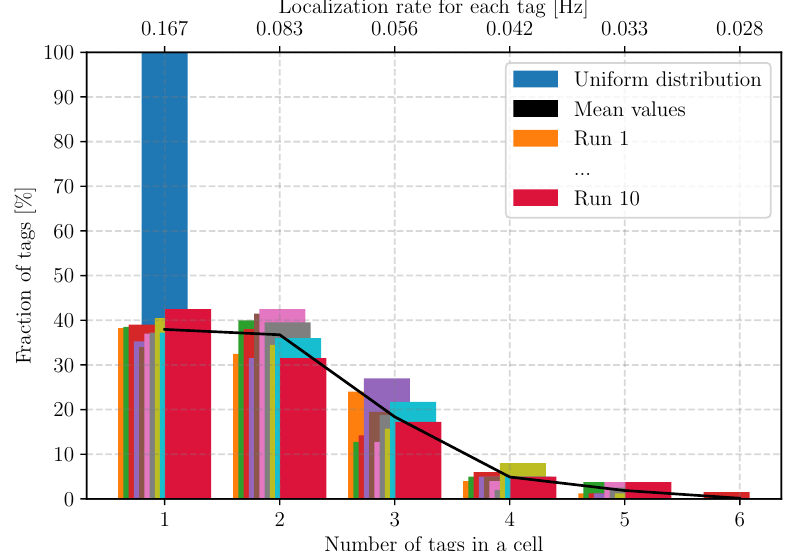
Figure 26. Distribution of tags in cells and at the same time distribution of the achieved position- ing